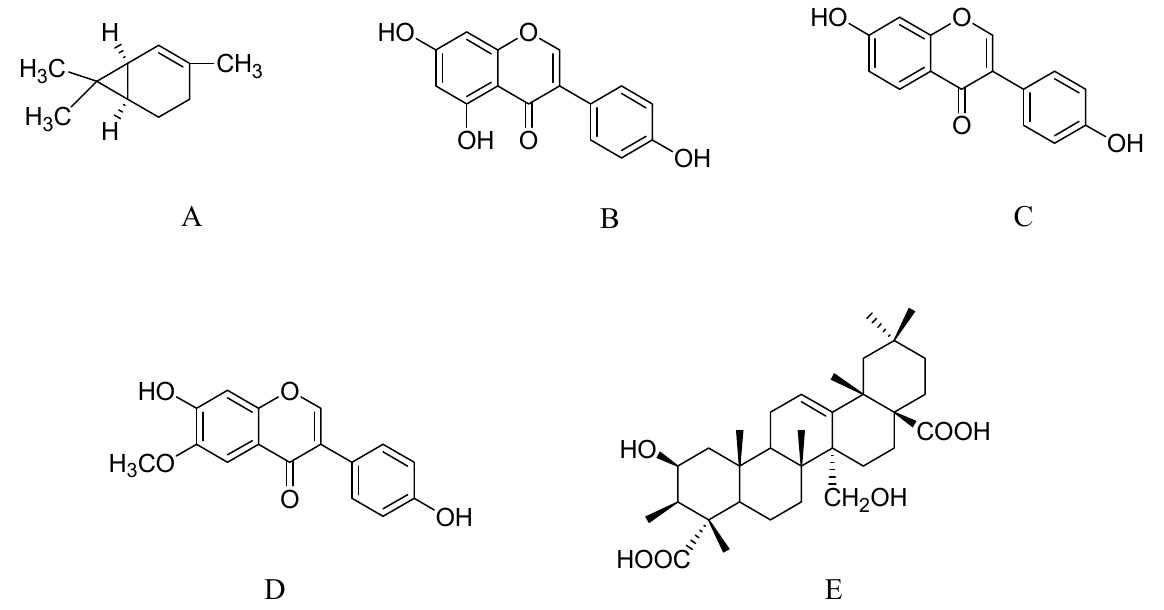
Figure 4. Molecular structures of carene ( A ), genistein ( B ), daidzein ( C ), glycitein ( D ), and presenegenin ( E